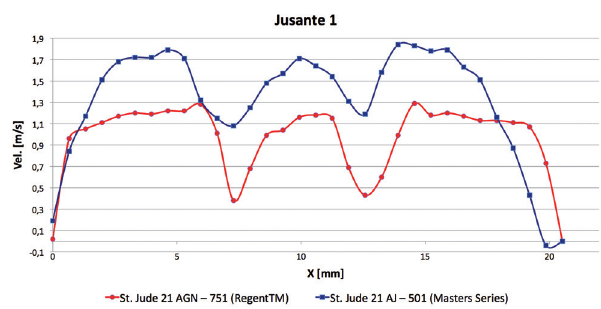
Fig. 6 - Velocity profiles at 8 mm downstream of the valves